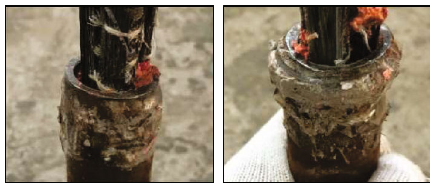
Figure 16: The plastic deformation of the end steel anchor